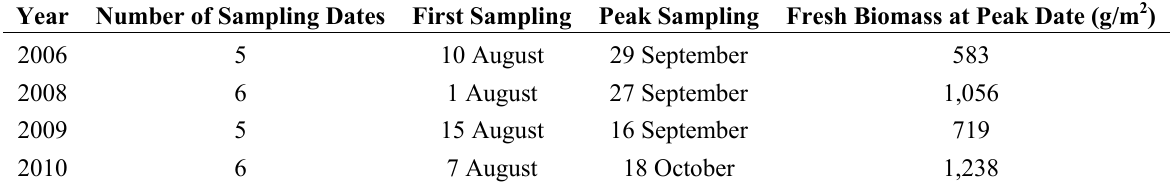
Table 2. Overview of Dahra biomass